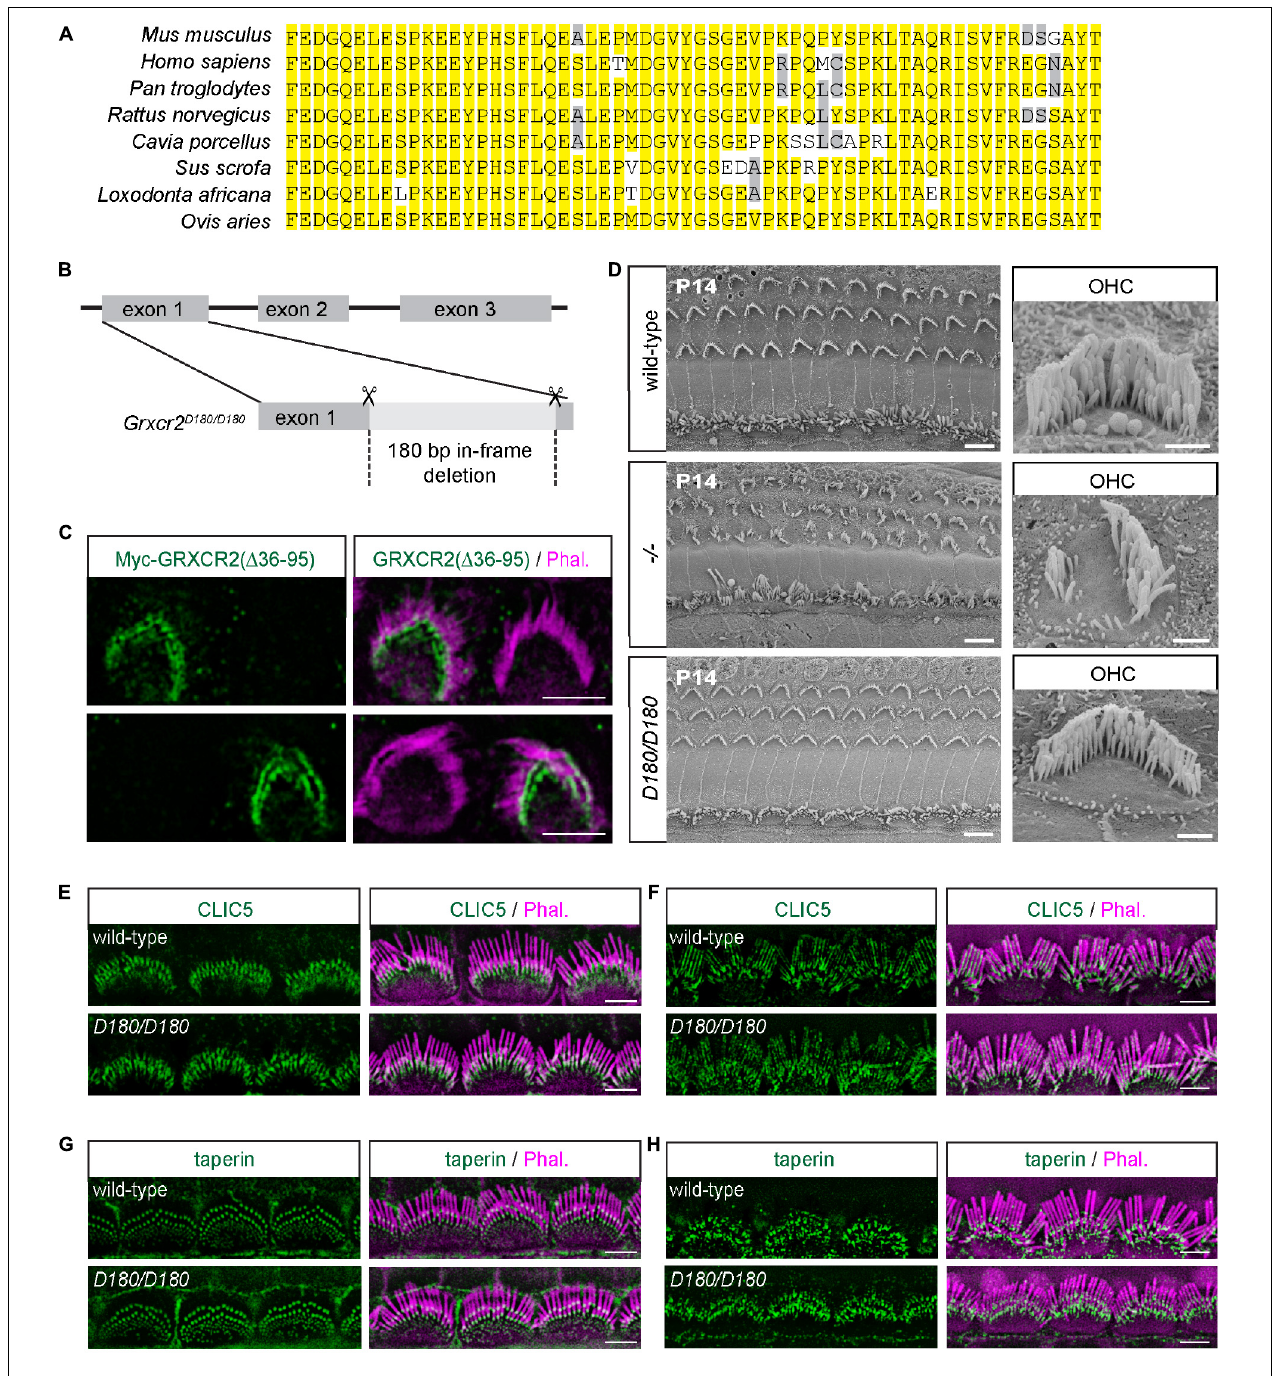
FIGURE 3 | Disrupting the interaction between GRXCR2 and CLIC5 has minimal effects on stereocilia morphogenesis. (A) Amino acids from 36 to 95 in GRXCR2 are highly conserved in mammals. (B) Diagram of the strategy to generate Grxcr2 D 180 / D 180 mice. sgRNAs targeting exon 1 of Grxcr2 induced a 180-bp in-frame deletion, which was confirmed by sanger sequencing. (C) P3 cochlear explants were injectoporated to express Myc-GRXCR2 ( (cid:49) 36–95). Two days later, tissues were fixed and stained with the Myc-antibody. Note Myc-GRXCR2 ( (cid:49) 36–95) was concentrated at the base of the stereocilia. (D) Scanning electron microscope images showing auditory sensory epithelia of wild-type (upper panel), Grxcr2 − / − (middle panel), and Grxcr2 D 180 / D 180 (lower panel) mice at the age of P14. Note, stereocilia of Grxcr2 − / − mice were disorganized while the stereocilia were fairly normal in Grxcr2 D 180 / D 180 mice. Scale bars: left panel 5 µ m, right panel 1 µ m. (E,F) Cochlear whole mounts from wild-type and Grxcr2 D 180 / D 180 mice at the age of P7 (E) and 6 weeks (F) were stained for CLIC5. Stereocilia were visualized by staining with phalloidin (red). Note, CLIC5 staining did not show any significant change in Grxcr2 D 180 / D 180 hair cells. (G,H) Cochlear whole mounts from wild-type and Grxcr2 D 180 / D 180 mice at the age of P7 (G) and 6 weeks (H) were stained for taperin. Note, taperin was still concentrated at the base of stereocilia in Grxcr2 D 180 / D 180 hair cells. Scale bars: 5 µ m.